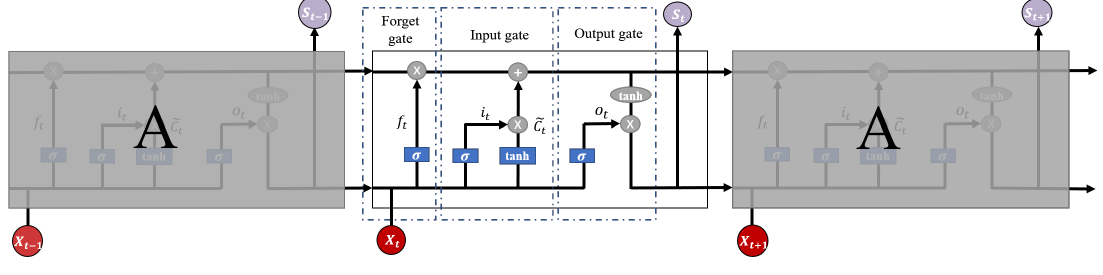
Figure 4. Diagram of an LSTM